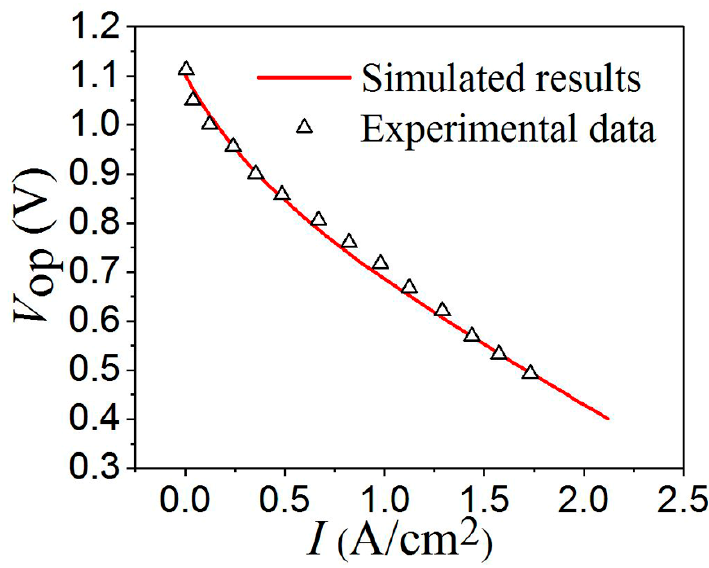
Figure 3. Model validation [24]. Table 3. Model parameters [24–27].